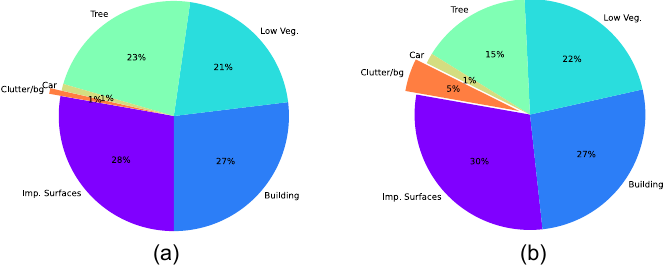
Figure 7. ( a ) Percentage of categories in Vaihingen benchmark. ( b ) Percentage of categories in Potsdam